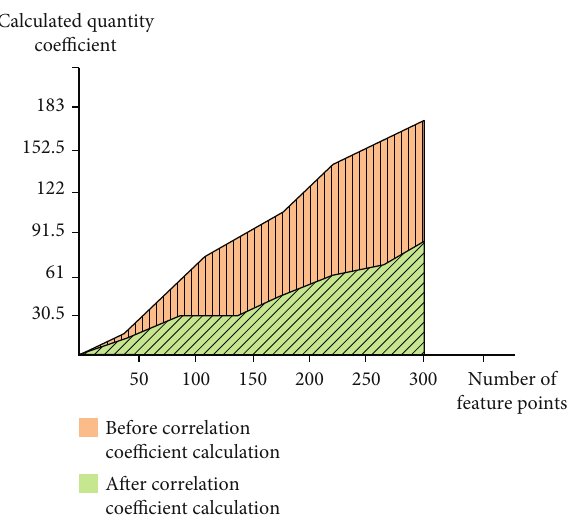
Figure 3: Comparison results of calculation amount before and after calculation of correlation coe ffi